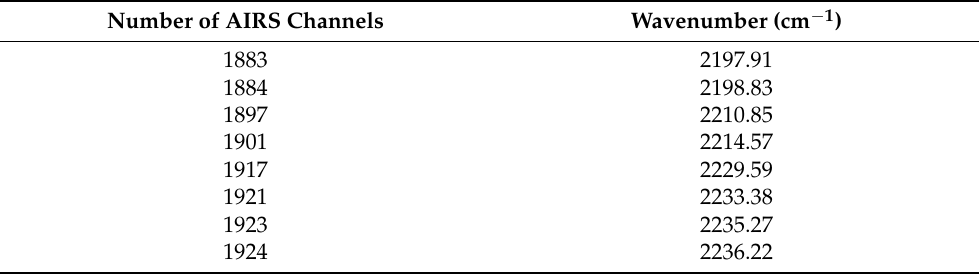
Table 1. The selected AIRS channels number for N 2 O retrieval using the OSP